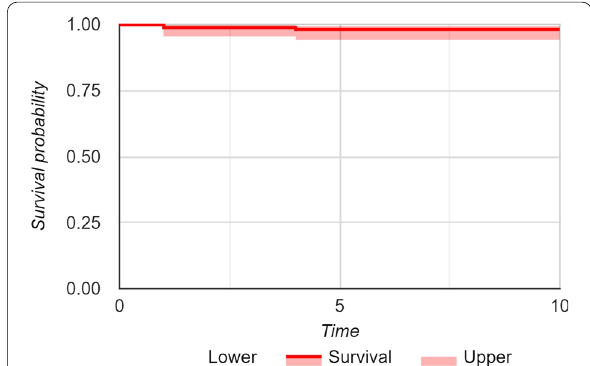
Fig. 3 Kaplan–Meier survivorship analysis after 10 years. Survival rate